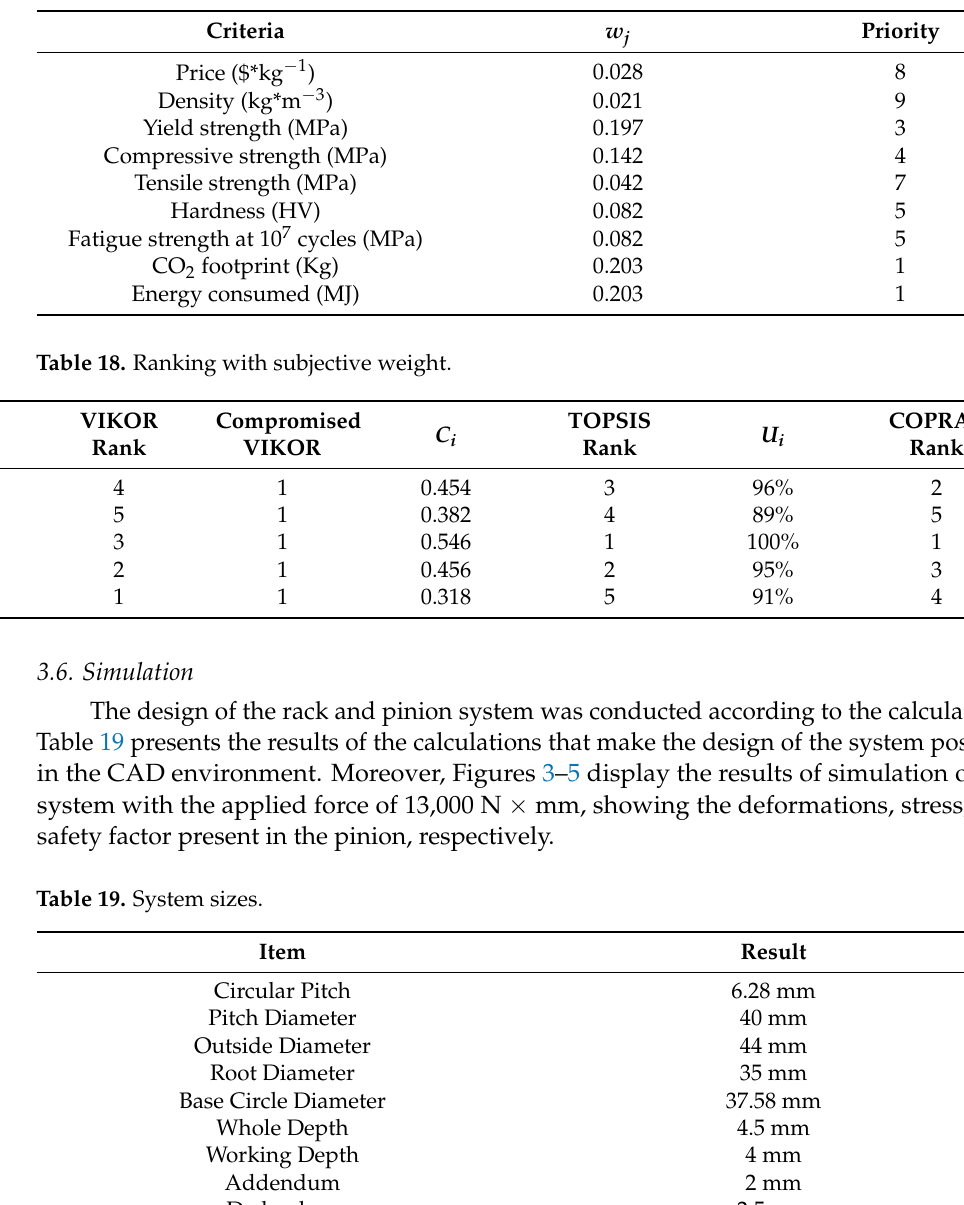
Table 17. AHP weight.